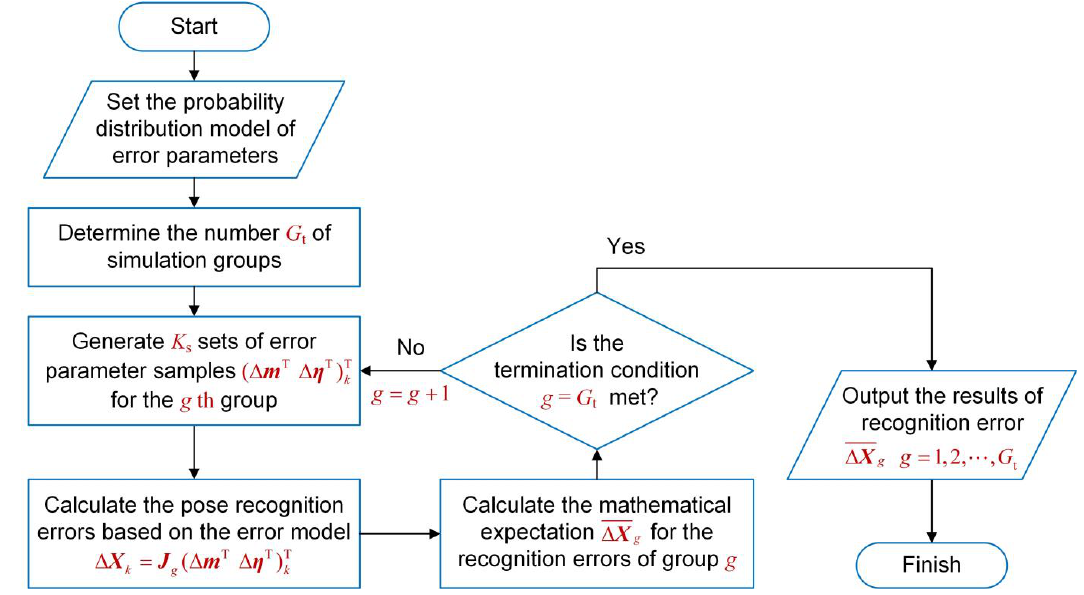
Figure 4. Flow chart of the single-factor analysis.